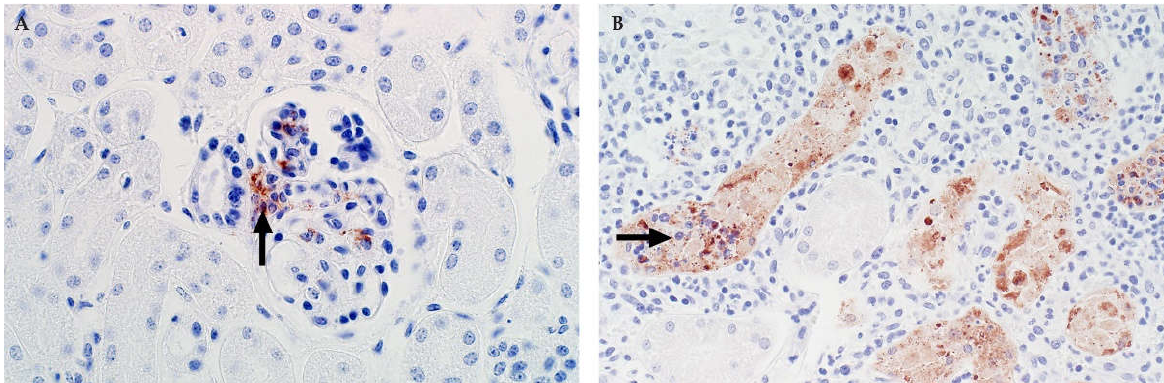
Figure 7. Immunolabelling for RVFV in the kidney of sheep (NovaRed IHC as detailed in Figure 5). ( A ) In this specimen from a young lamb, viral antigen is prominent in Lacis cells in the glomerulus (arrow). Other cells, morphologically consistent with endothelial cells also labelled in the glomerulus. Cells in the macula densa are not labelled, mag 400×. ( B ) Adult sheep with immunolabelling of necrotic renal tubular epithelial cells (arrow) in the renal cortex, mag 600×.